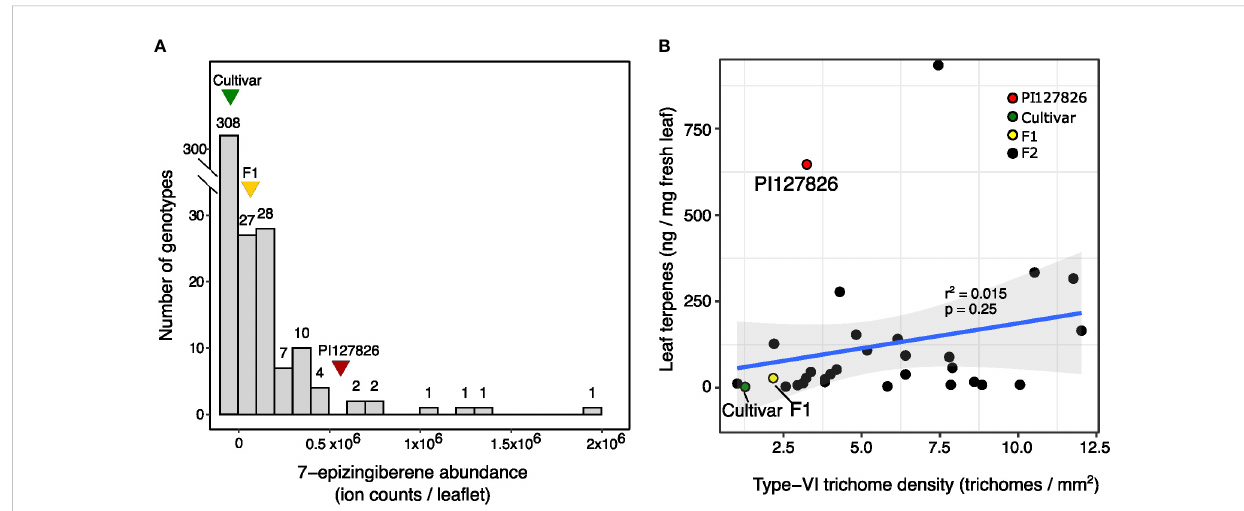
FIGURE 2 Distribution of 7-epizingberene levels and trichome density of the F2 population. (A) Histogram shows the distribution of 7-epizingiberene levels on lea fl ets of 393 F2-genotypes selected for the presence of zFPS , ZIS , and ShZO. F2 plants are assigned to bins of ion counts of the 7-epizingiberene peak as determined by GC-MS. The width of each bin represents one time the standard deviation of 7-epizingiberene in PI127826 (n =4), with the fi rst bin displaying the number of F2 genotypes with zero ion counts. The number on top of each bar displays the number of F2 genotypes assigned to the particular bin. Triangles indicate the bin with the average 7-epizingiberene levels of the respective parental genotypes (n = 4). (B) Scatterplot showing the type-VI trichome density of the sub-population (averaged abaxial/adaxial) versus the total terpene levels (i.e. summed mono-and sesquiterpenes) on the leaves of F2 plants from the sub-population. The blue line indicates the linear correlation plus 95% con fi dence interval (grey). The correlation coef fi cient (r 2 ) and p-value are displayed on top of the line. Each dot represents measurements of an individual